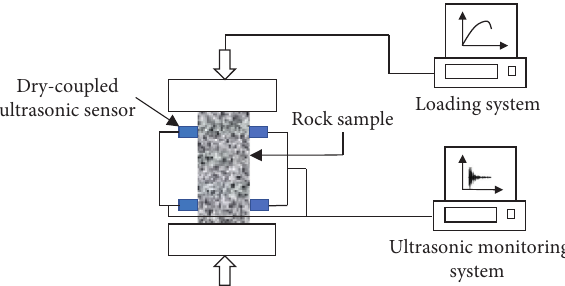
Figure 2: Schematic diagram of mechanical loading and ultrasonic monitoring system.